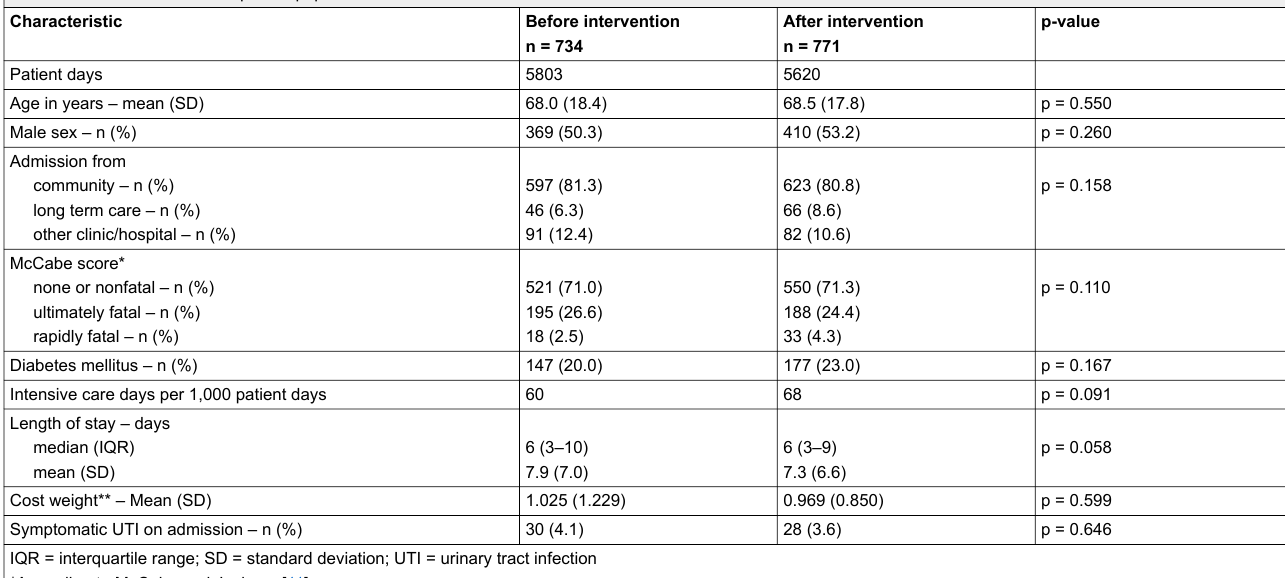
Table 1: Characteristics of the patient populations before and after the intervention.